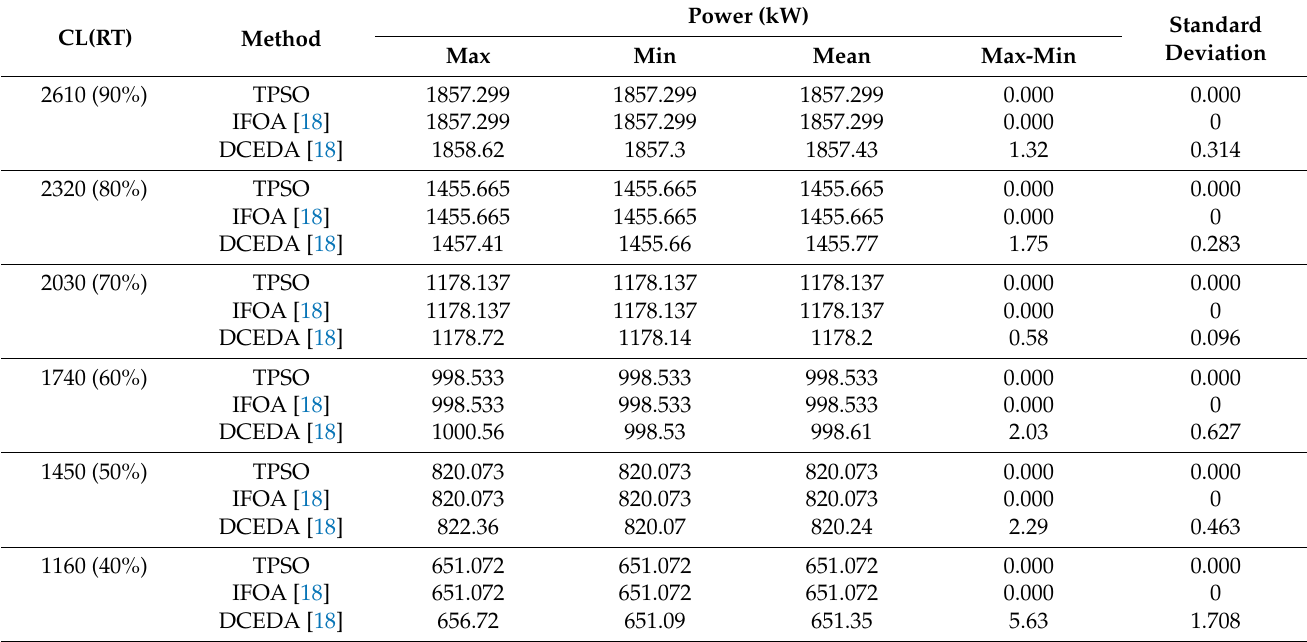
Table 17. Comparison of stability yielded by TPSO, IFOA and DCEDA in Case